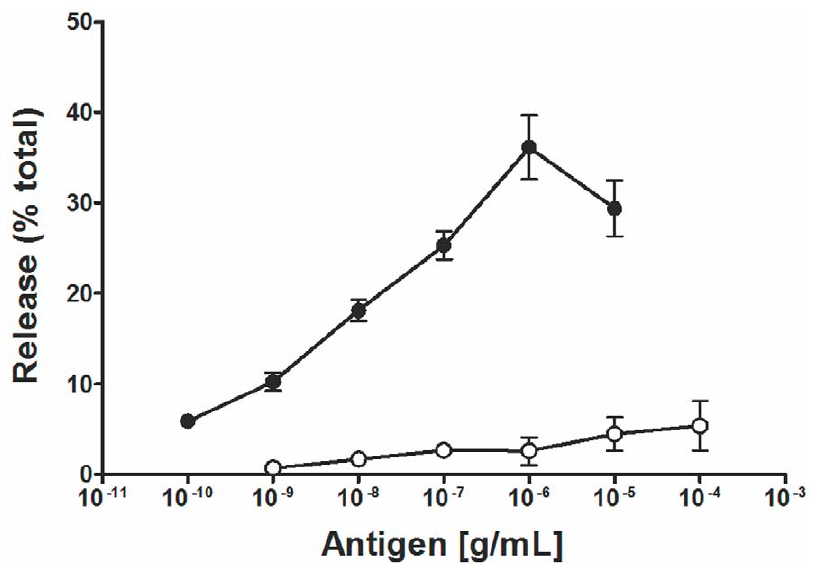
N Figure 3. IgE cross-reactivity between Poly s 5 and Pol a 5. RBL cells were loaded with IgE from mice immunized with Pol a 5 and then ) or Poly s 5 ( # ). Mean percentages of b -hexosaminidase release of duplicates 6 S.E.M. are exposed to increasing concentrations of either Pol a 5 ( displayed.